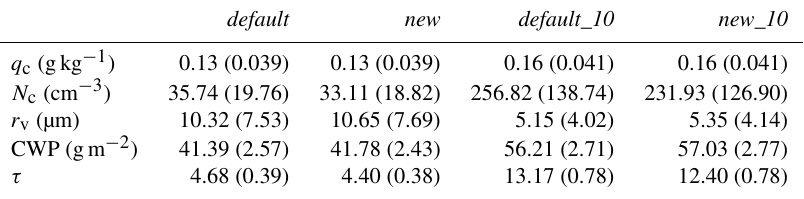
Figure 3. The temporal evolutions of main cloud microphysical and optical properties in all simulation experiments for the cumulus case, including (a) cloud water mixing ratio ( q c ) (gkg − 1 ), (b) cloud droplet number concentration ( N c ) (cm − 3 ), (c) cloud droplet volume mean radius ( r v ) (µm), (d) cloud water path (CWP) (gm − 2 ), and (e) cloud optical depth ( τ ). In (b) , N c values in the experiments default and new are normalized by the maximum cloud droplet concentration ( N cmax ) from default ; N c values in the experiments default_10 and new_10 are normalized by N cmax from default_10 . The four experiments are detailed in Table 1. Table 3. Summary of the case mean values of the key quantities in all the simulations of the stratocumulus case, including cloud water mixing ratio ( q c ), cloud droplet number concentration ( N c ), cloud droplet volume mean radius ( r v ), cloud water path (CWP), and cloud optical depth ( τ ). The numbers in and out of the parentheses are the results at the mature and dissipation stages, respectively. The experiments are detailed in Table